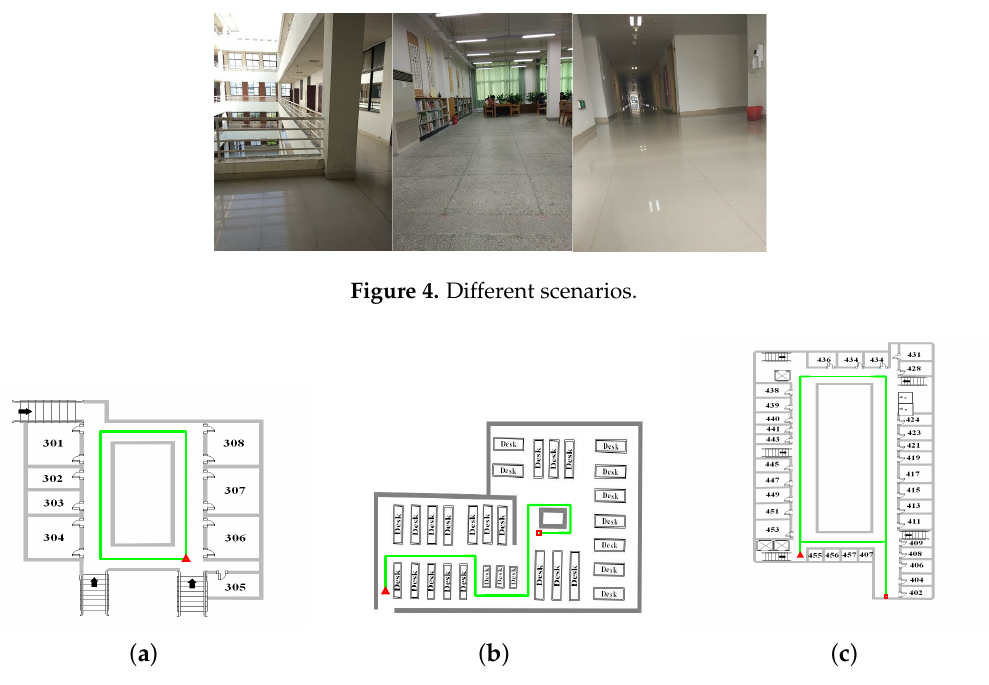
Figure 5. The walking trajectory: ( a ) teaching building; ( b ) study room; ( c ) office